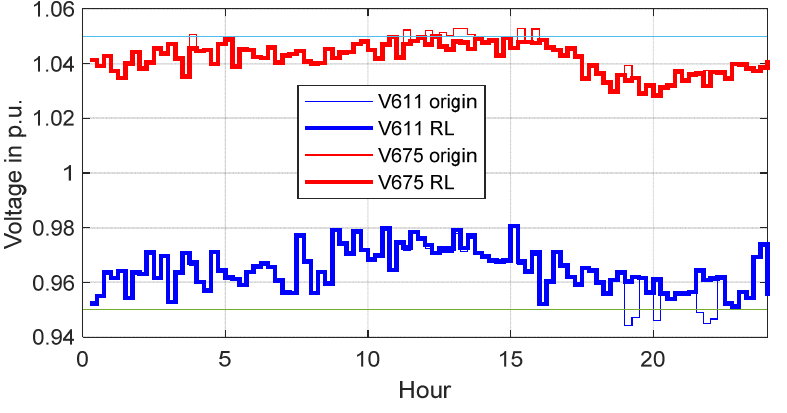
Figure 4. Voltage regulation results.